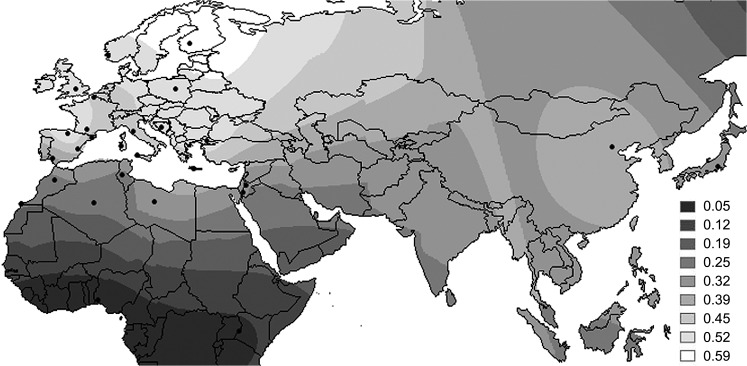
Contour map of the MAF of the CAD risk SNP rs1333042 potentially positive selected in the 9p21 region.